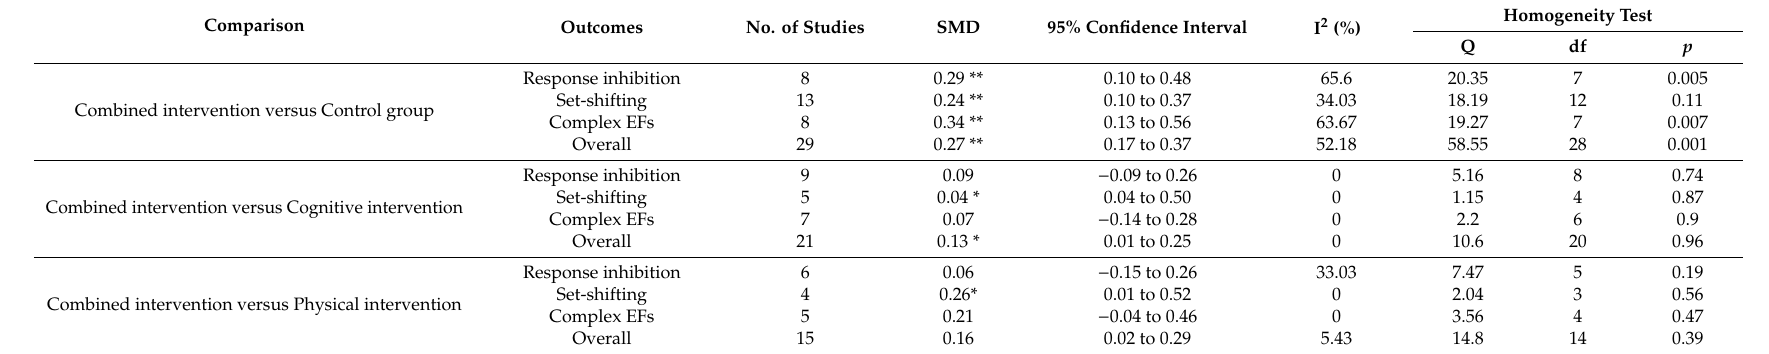
Table 2. E ff ect Sizes of the Combined Interventions on Response Inhibition, Set-Shifting, and Complex EFs.